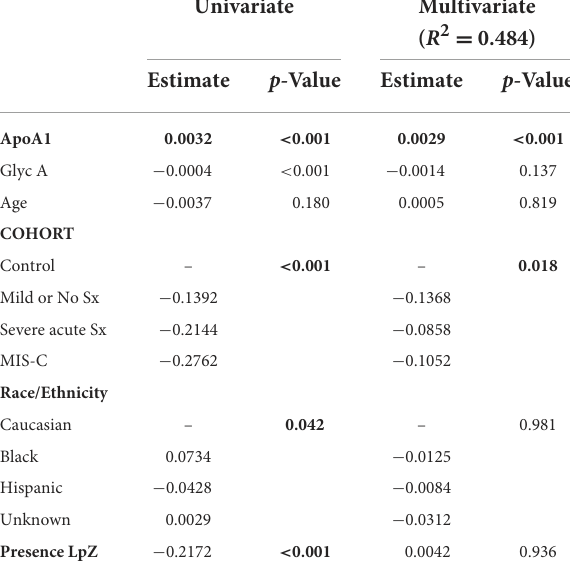
TABLE 5 Modeling of high density lipoprotein cholesterol efflux